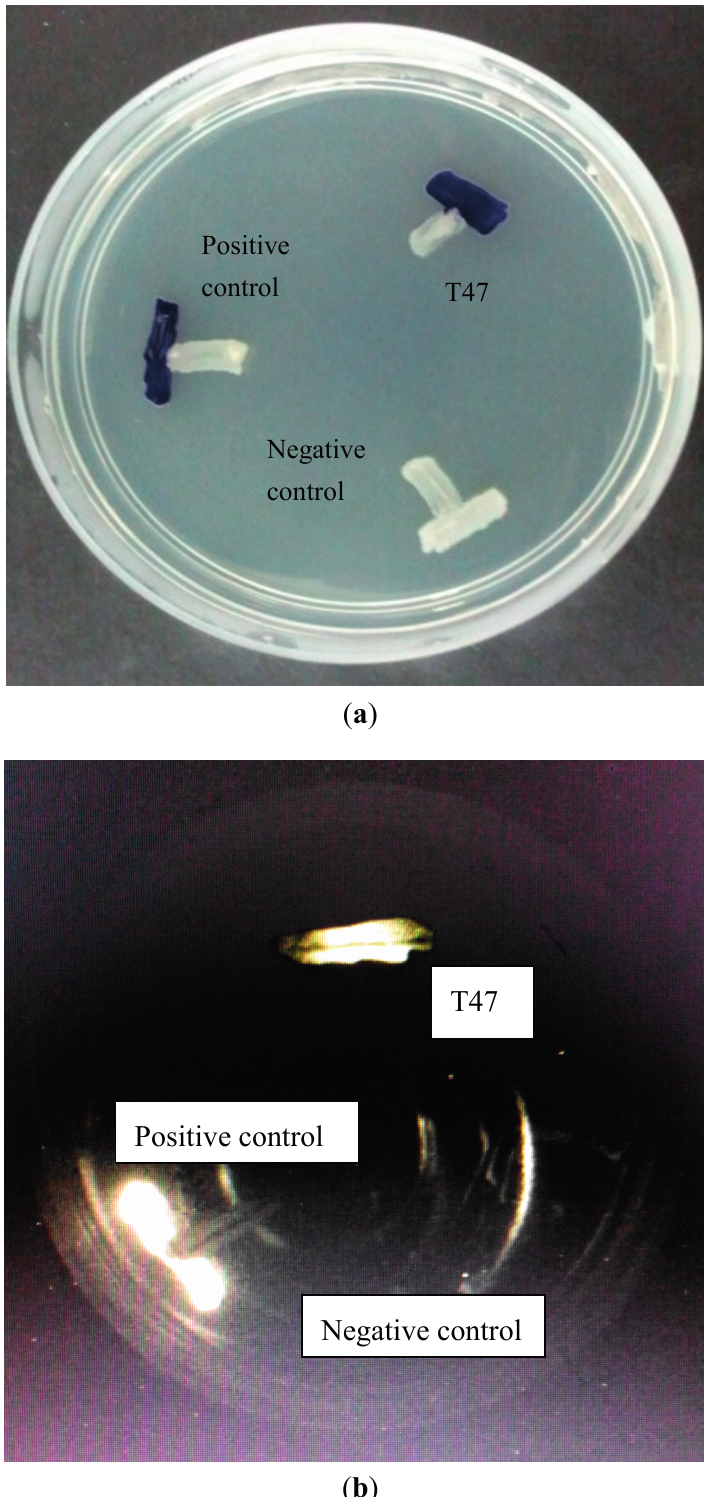
Figure 1. ( a ) AHL screening of strain T47 with C. violaceum CV026 and ( b ) with E. coli pSB401. E. carotovora PNP22 (negative control) devoid of QS activity was included and E. carotovora GS101 (positive control) that can activate C. violaceum CV026 and E. coli pSb401 was